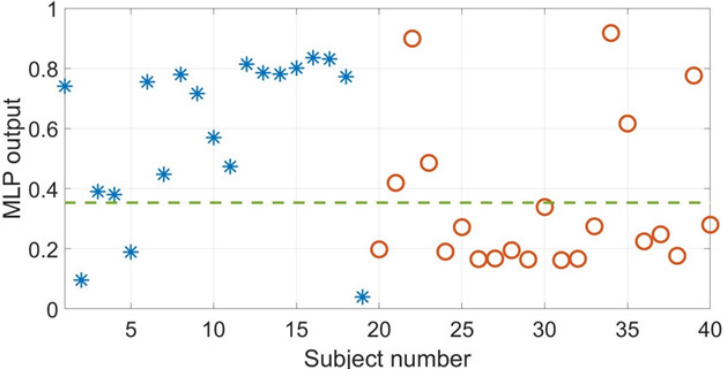
Figure 9. Plot of averaged multilayer perceptron outputs (over 100 trials) for participants in the test file in investigation A. The stars and circles represent participants with fracture and sprain, respectively. The dashed line is the threshold.